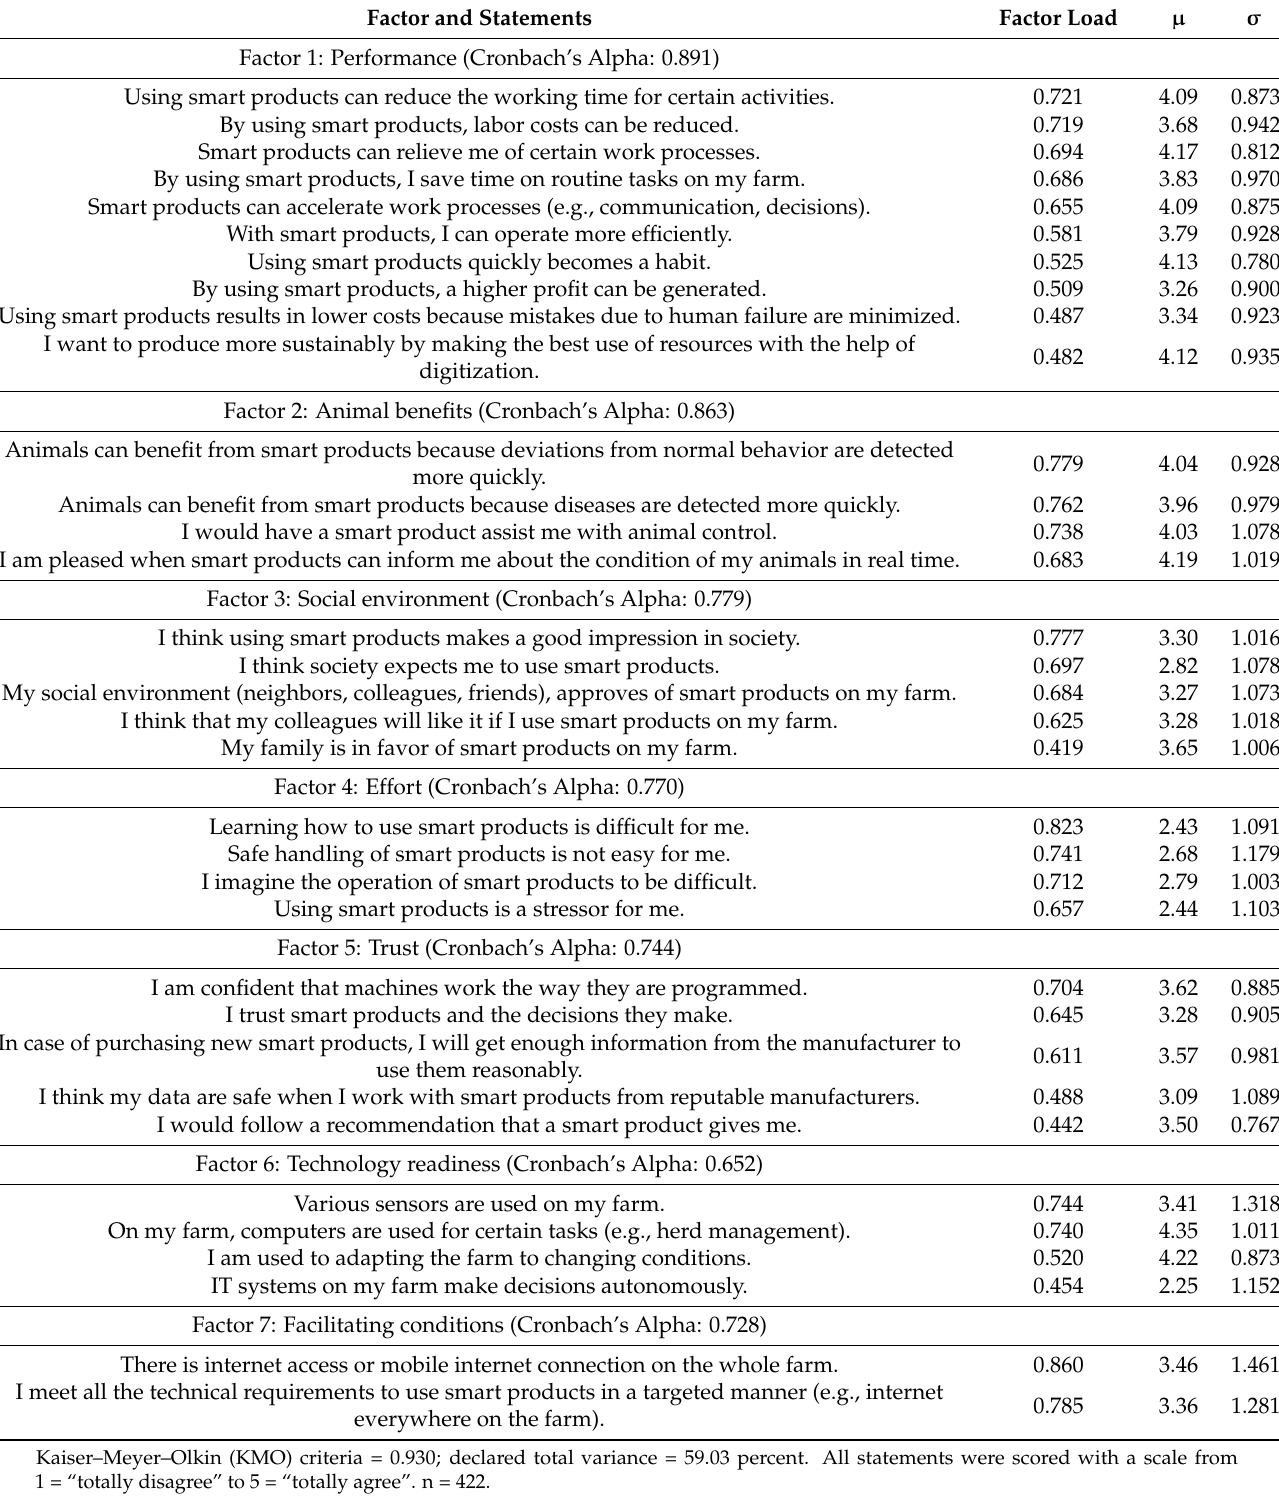
Table 1. Results of the factor